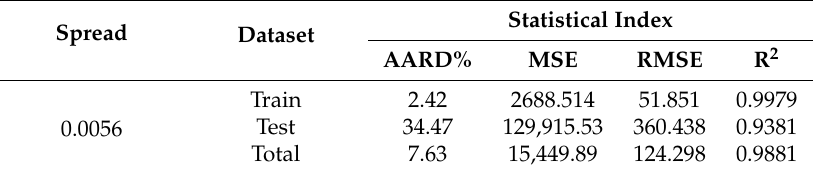
Table 7. Accuracy of the general regression (GR) for prediction.